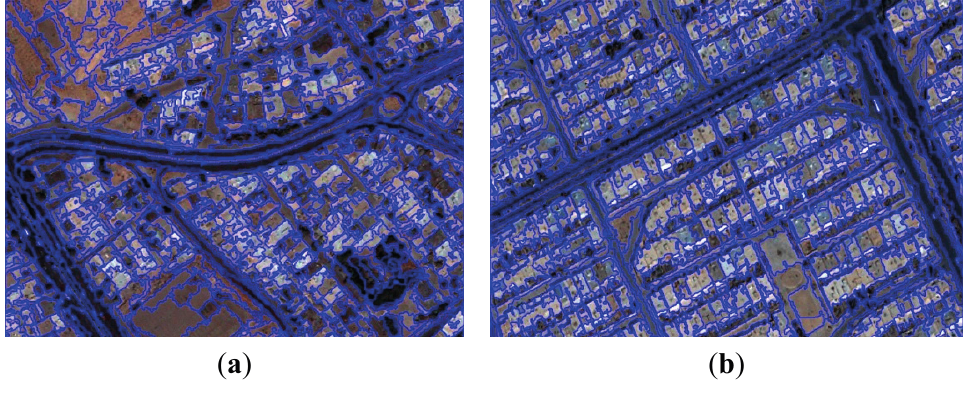
Figure 11. A segmented view of: ( a ) Shiraz image; ( b ) Yazd image.